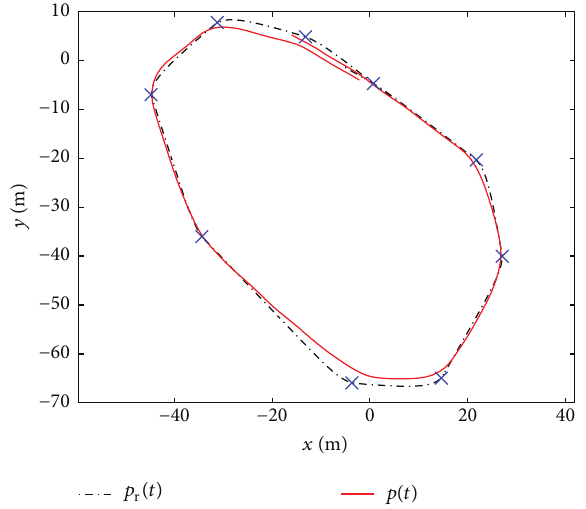
Figure 15: Tracking performance at 5m / s. The crosses are desired waypoints.